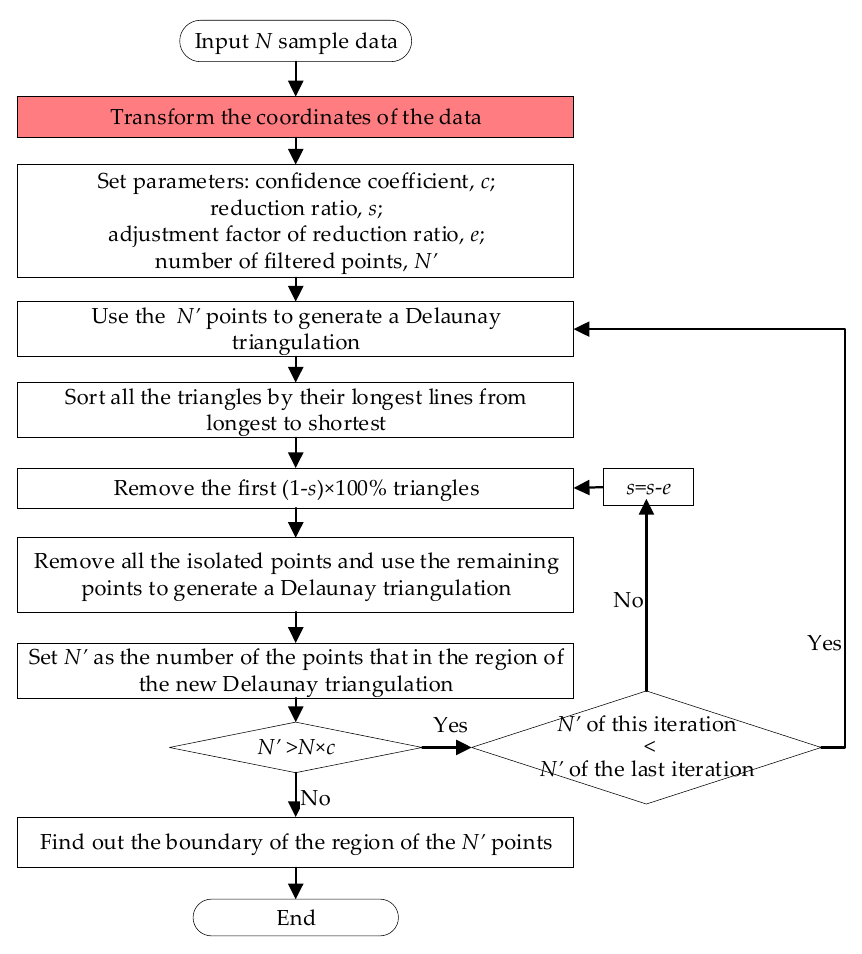
Figure 7. The process of selecting points according to the confidence coefficient.